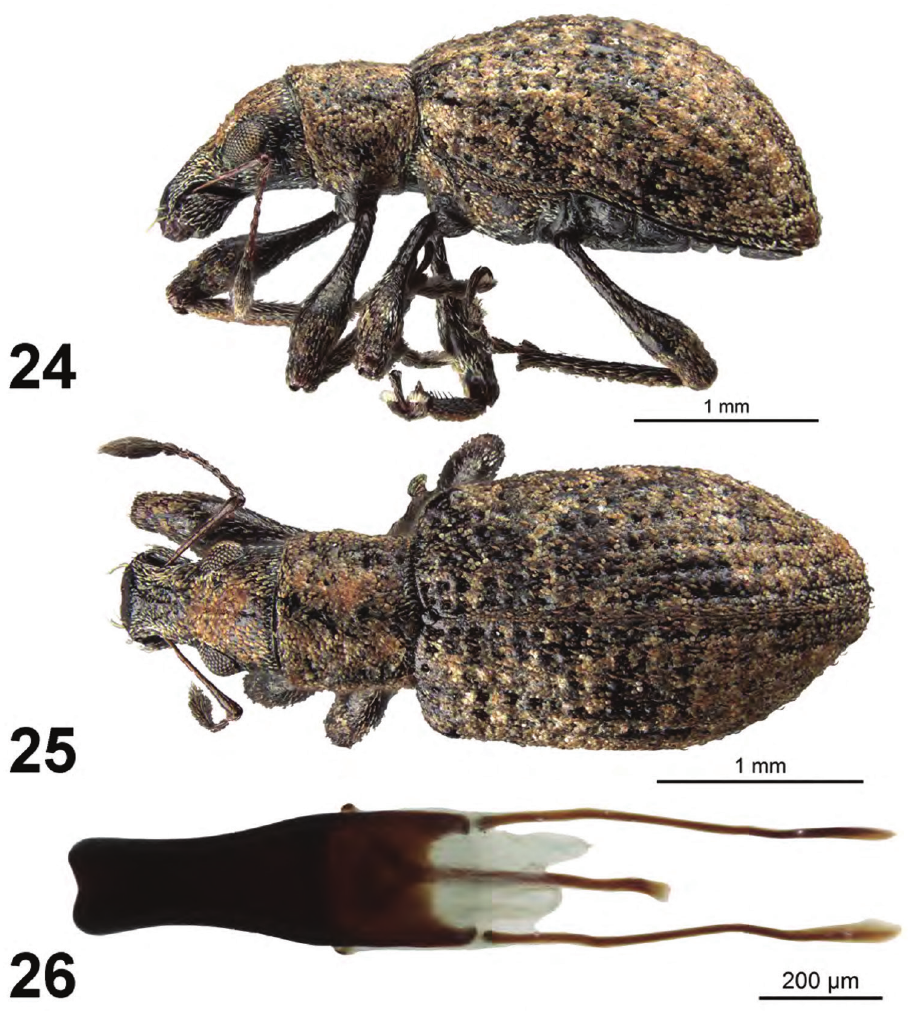
Figures 24–26. Apodrosus zayasi. 24 Lateral habitus, female 25 Dorsal habitus, female 26 Male aedeagus,